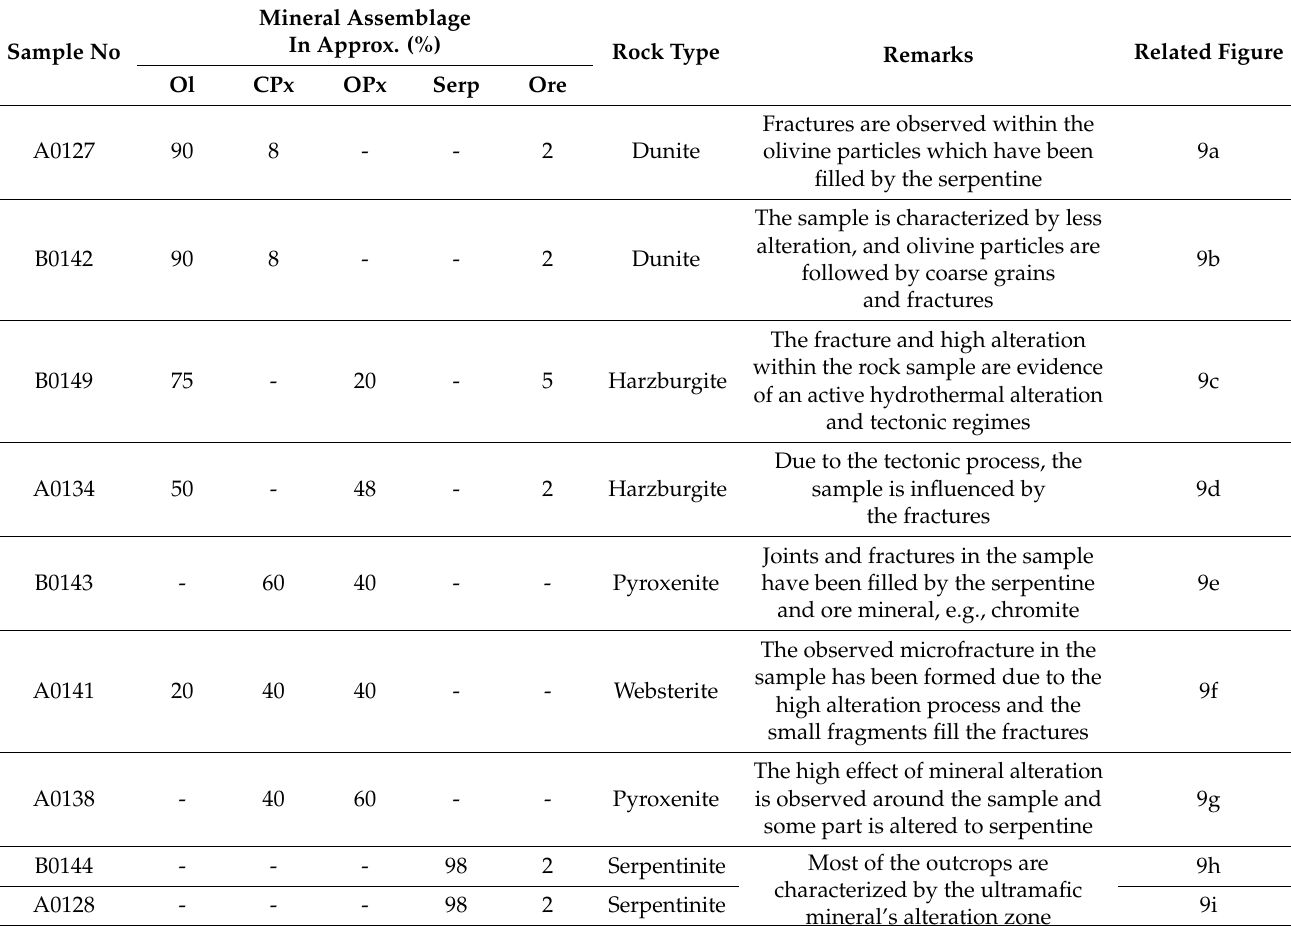
Table 2. Description of analyzed thin sections from collected